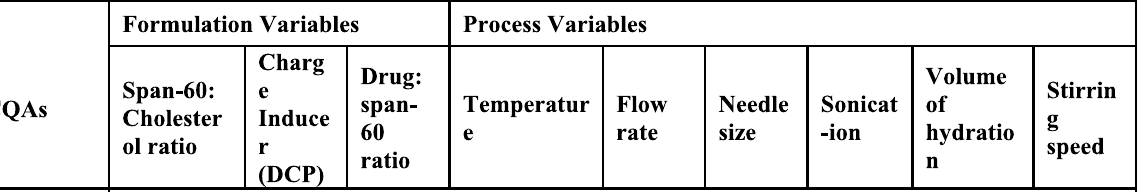
Table 5 Initial and updated risk assessment of the formulation